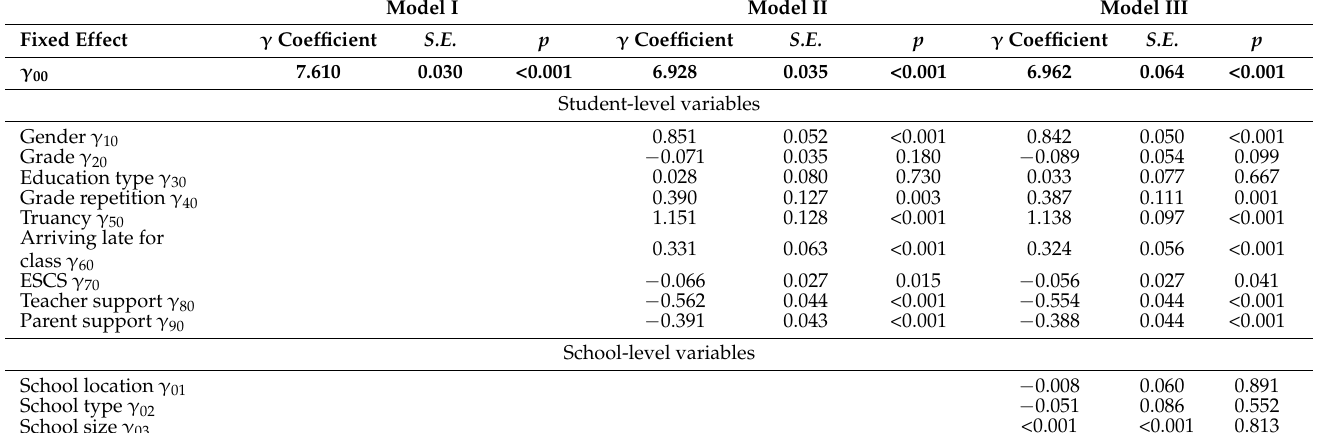
Table 2. Multilevel analysis results of the influencing factors of students suffering from school bullying. Model I Model II Model